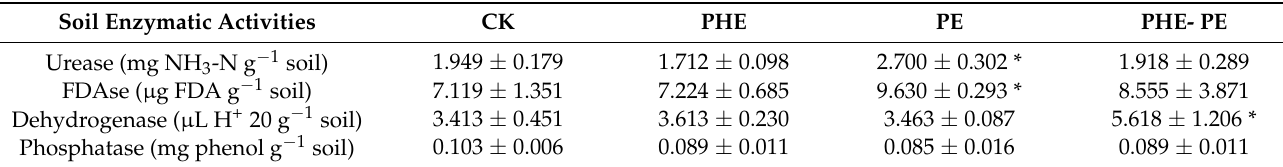
Table 2. The soil enzymatic activities of all